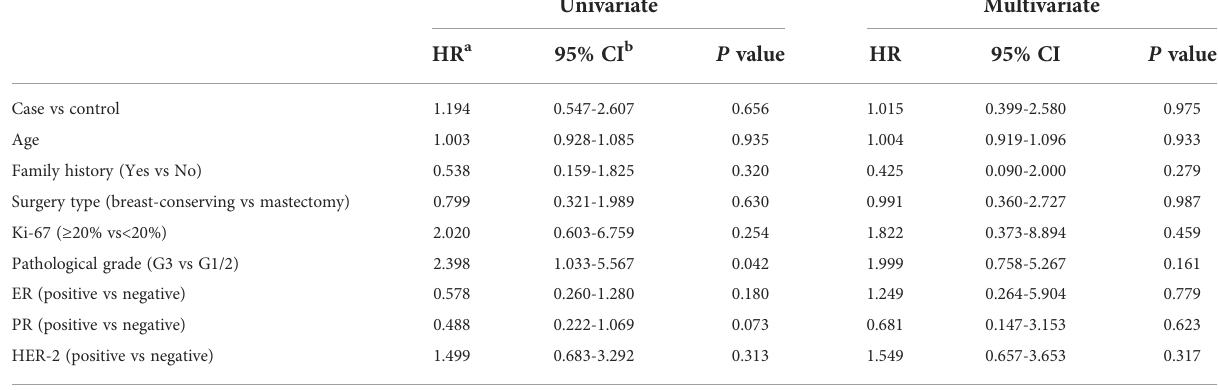
TABLE 2 Factors associated with recurrence among PABC patients and their controls.